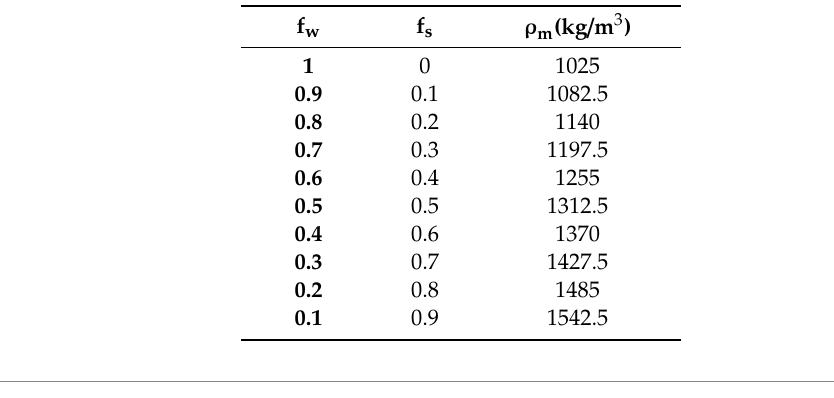
Table 4. The Terry and Malik [77] relationship between seawater fraction (f w ) and sand fraction (f s ) connected to the average density of the seawater and sediment mix ( ρ m ).